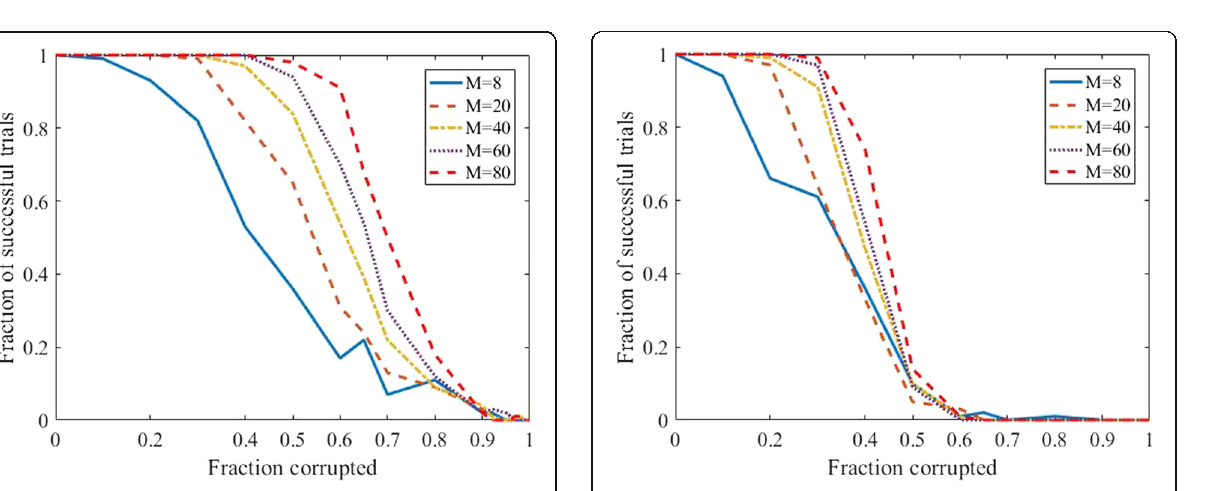
Fig. 6 Error correction in L1 optimization when m ∈ {8, 20, 40, 60, 80} and ‖ x 0 ‖ =